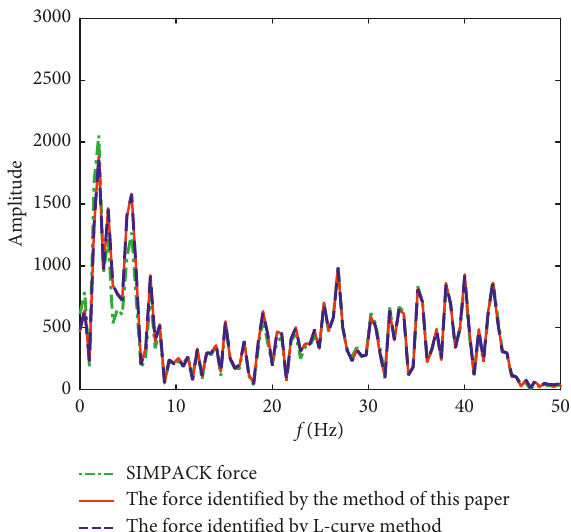
Figure 20: Amplitude-frequency curve of the two methods for F 4 identification when the noise level is